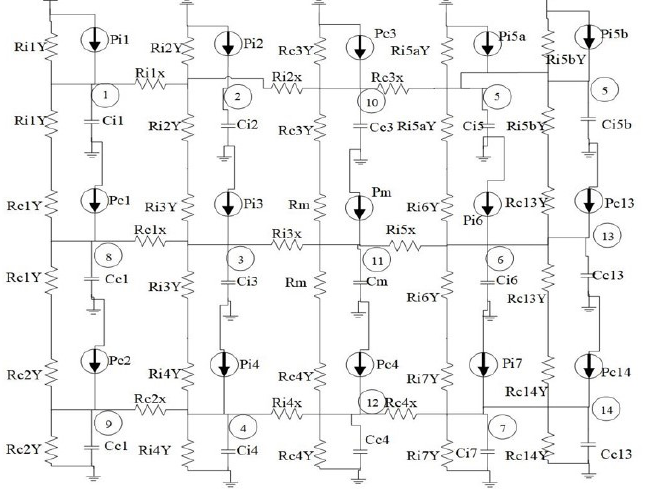
Figure 21. LPMEC model.